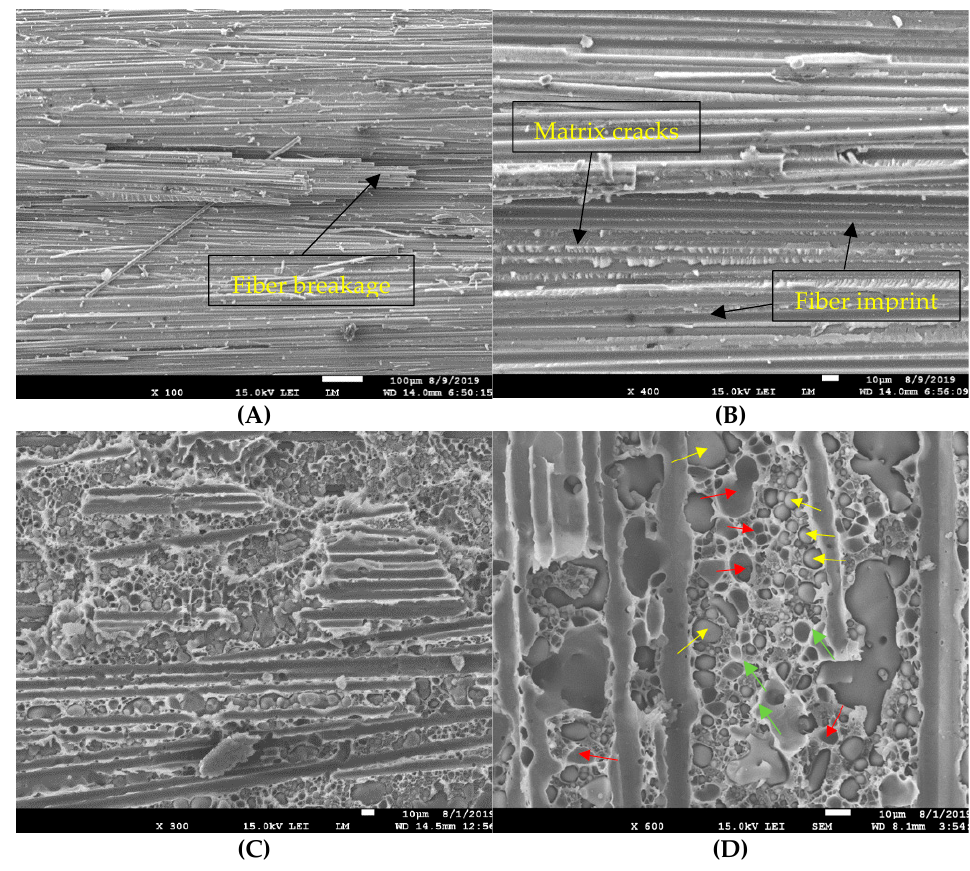
Figure 4. Fracture surfaces of ( A,B ) the reference and ( C,D ) the nanomodified laminates. The effect of the nanofibrous mat thickness on the fracture toughness is schematically illustrated in Figure 5. When the thickness was enhanced, the number of spherical particles increased. In this way, the number of crack deviations also increased. This meant that the crack traveled on a longer path. Both these parameters increased the required energy needed for crack propagation. Enhancing the thickness of the mat can also increase the possibility of other toughening mechanisms occurring, such as bridging caused by particles.